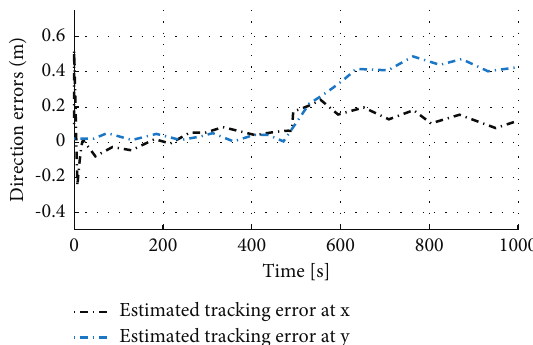
Figure 12: X and Y velocity components of disturbance.